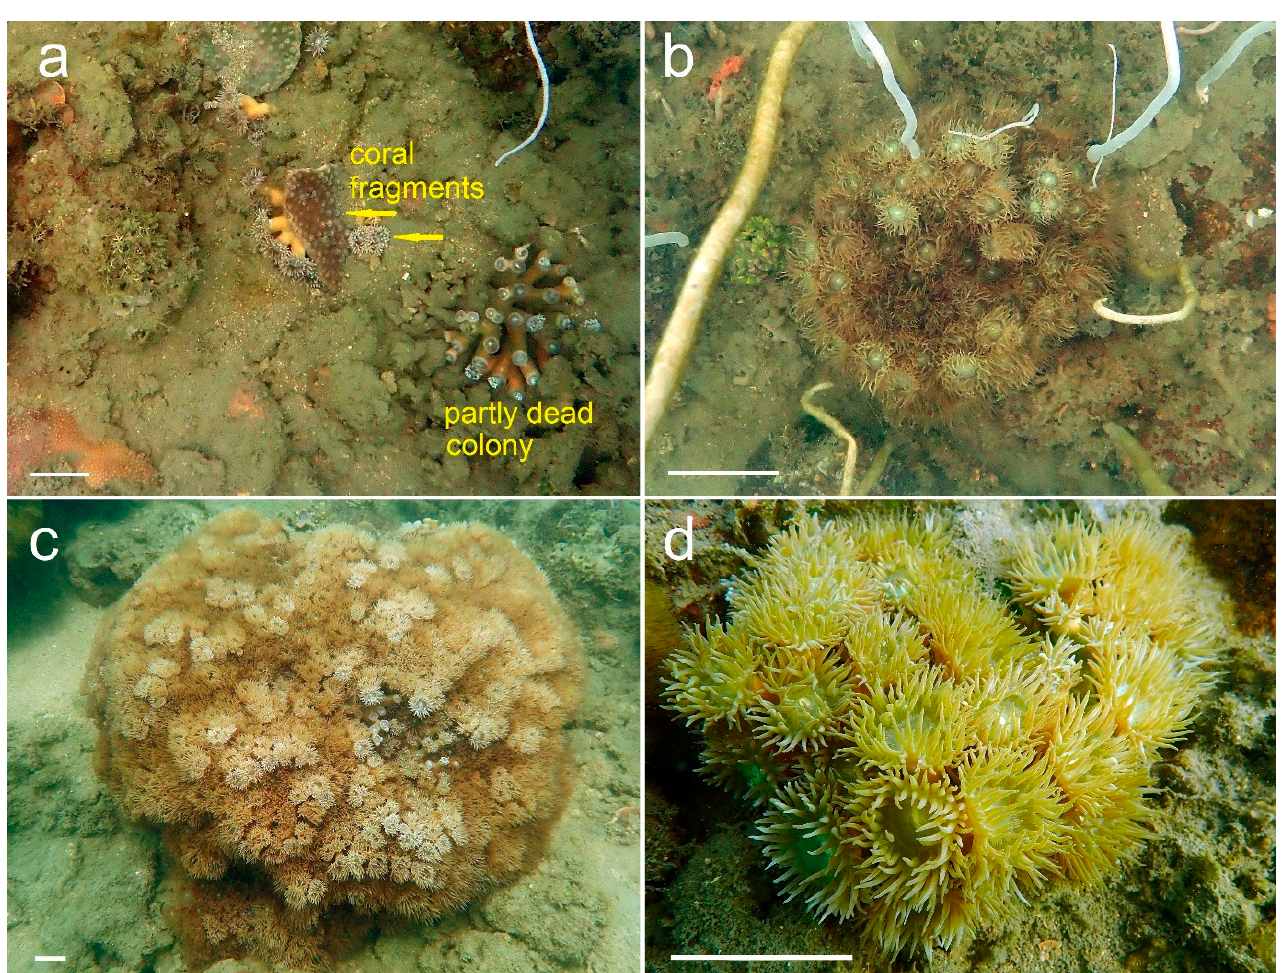
Figure 2. Habitat of Duncanopsammia axifuga in West Papua. ( a ) The bottom consists of fine sediment and dead coral; some Duncanopsammia colonies were attached to coral fragments (arrows) and another one had branches that were dead at the basis. ( b ) Coral colony surrounded by whip corals. ( c , d ) A large and a small colony with tentacles extended. Scale bars: 5 cm.